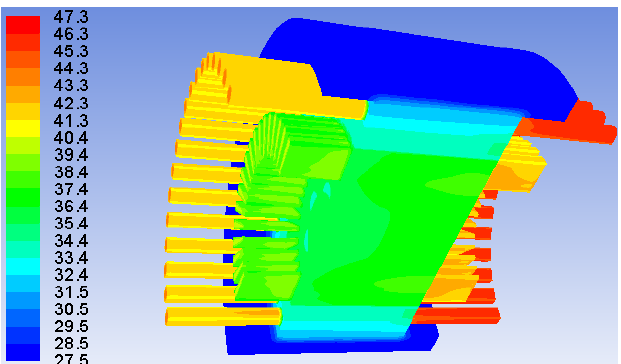
Figure 19. Thermal field distribution under condition of water cooling used in the casing and axial forced air when both the SM and the DRM run at the low speed and rated